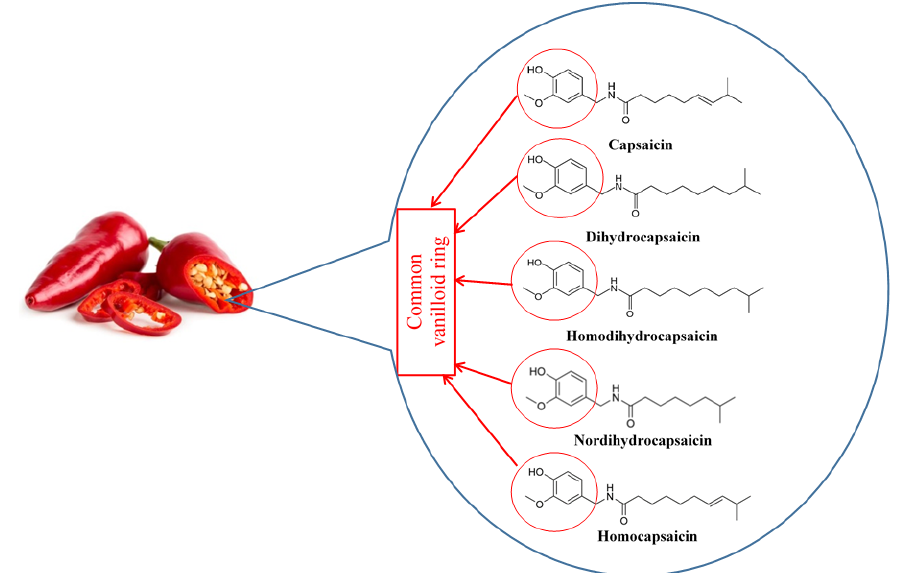
Figure 1. Chemical structure of capsaicinoids.